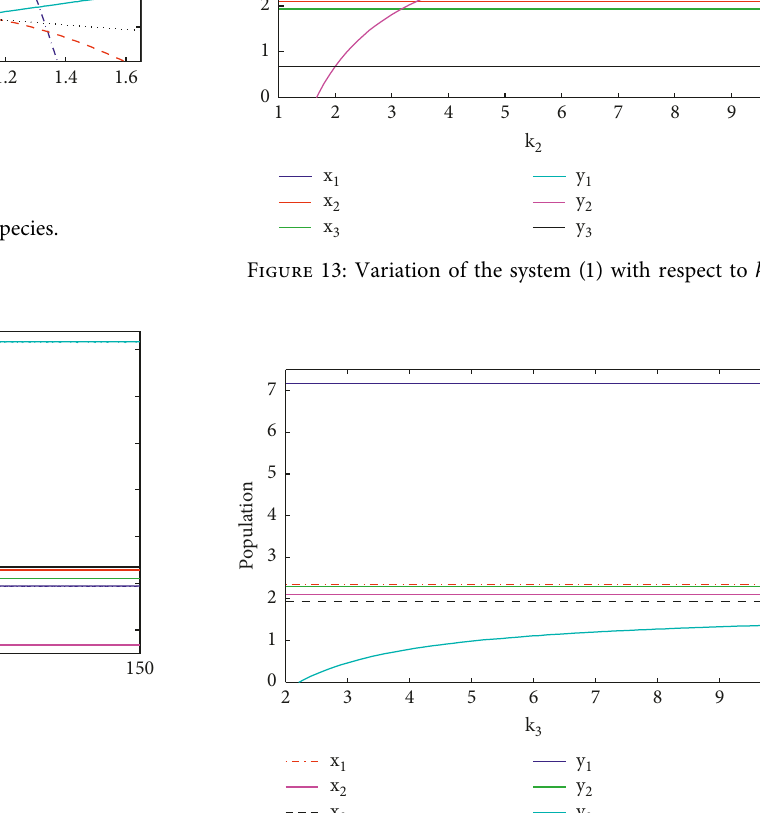
Figure 11: Time series plot of the system (1) with initial condition ( 3 . 1 , 3 . 5 , 3 . 7 , 0 . 3 , 0 . 4 , 0 . 5 ) .